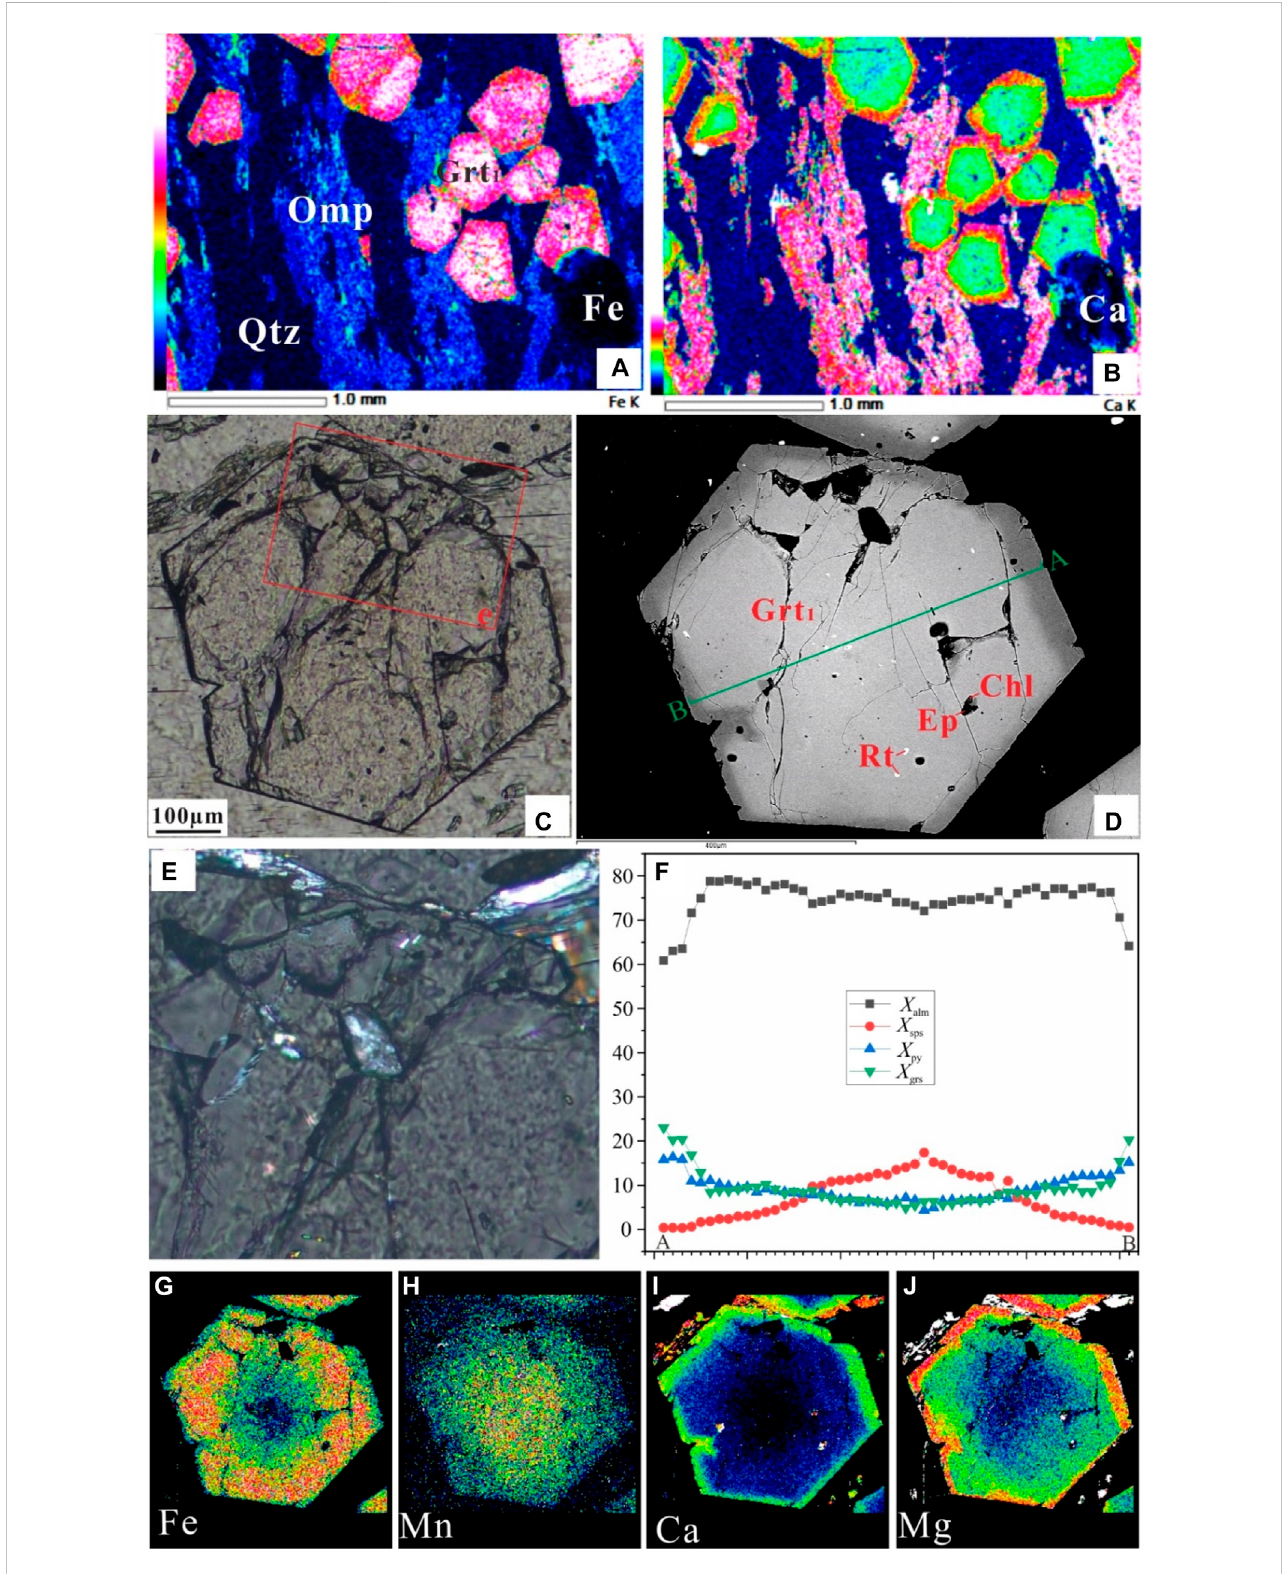
Garnets in the eclogite-dominated area. (A, B) Garnets commonly develop chemical zoning. (C – J) Representative coesite pseudomorph-bearing garnet. (C) Plane-polarized light. (D) Backscattered electron (BSE) image. (E) Enlargement of the coesite pseudomorph composed of polycrystalline quartz in c. (F) Garnet zoning pro fi le with X alm (= Fe 2+ /[Ca + Mg + Fe 2+ + Mn]), X sps (= Mn/[Ca + Mg + Fe 2+ +Mn]), X py (=Mg/[Ca + Mg + Fe 2+ + Mn]), and X grs (=Ca/[Ca + Mg + Fe 2+ + Mn]). (G – J) X-ray maps show the well-preserved growth zones of Fe, Mn, Ca, and Mg in this